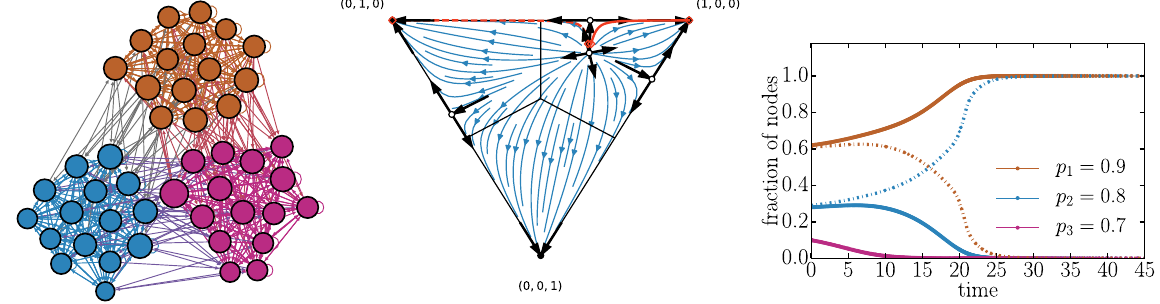
Figure 6. Dynamical trajectories in a modular competition between p 1 = 0.9, p 2 = 0.8, and p 3 = 0.7. (left) Example of a network built from three defensive strategies leads to three distinct modules. The network display style is the same as used in Fig. 2. (middle) Flow diagram of the voter model dynamics given these three defensive strategies shows the three basins of attractions. (right) Example of two time series with slightly different initial conditions shows how the final outcomes of the competition can change. The one with full markers starts at (0.62, 0.28, 0.1) and the one shown with a dotted line starts at (0.61, 0.29, 0.1).